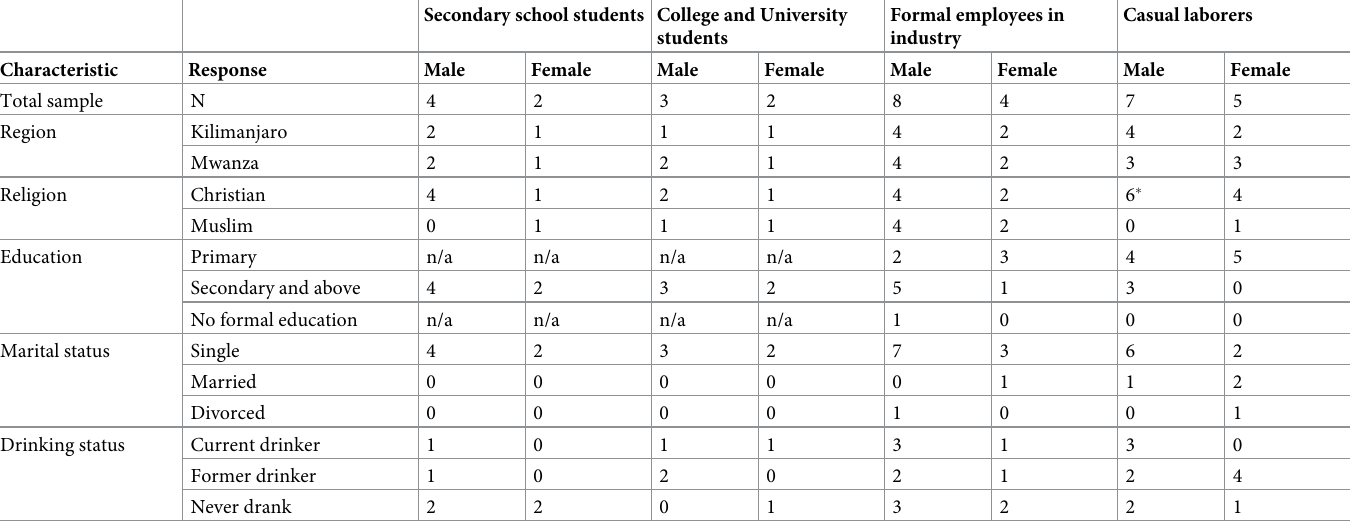
Table 1. Socio demographic and behavioral characteristics of study